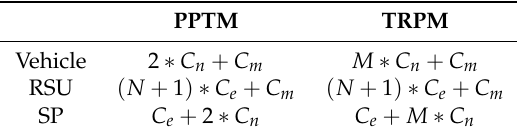
Table 1. Comparison of computational